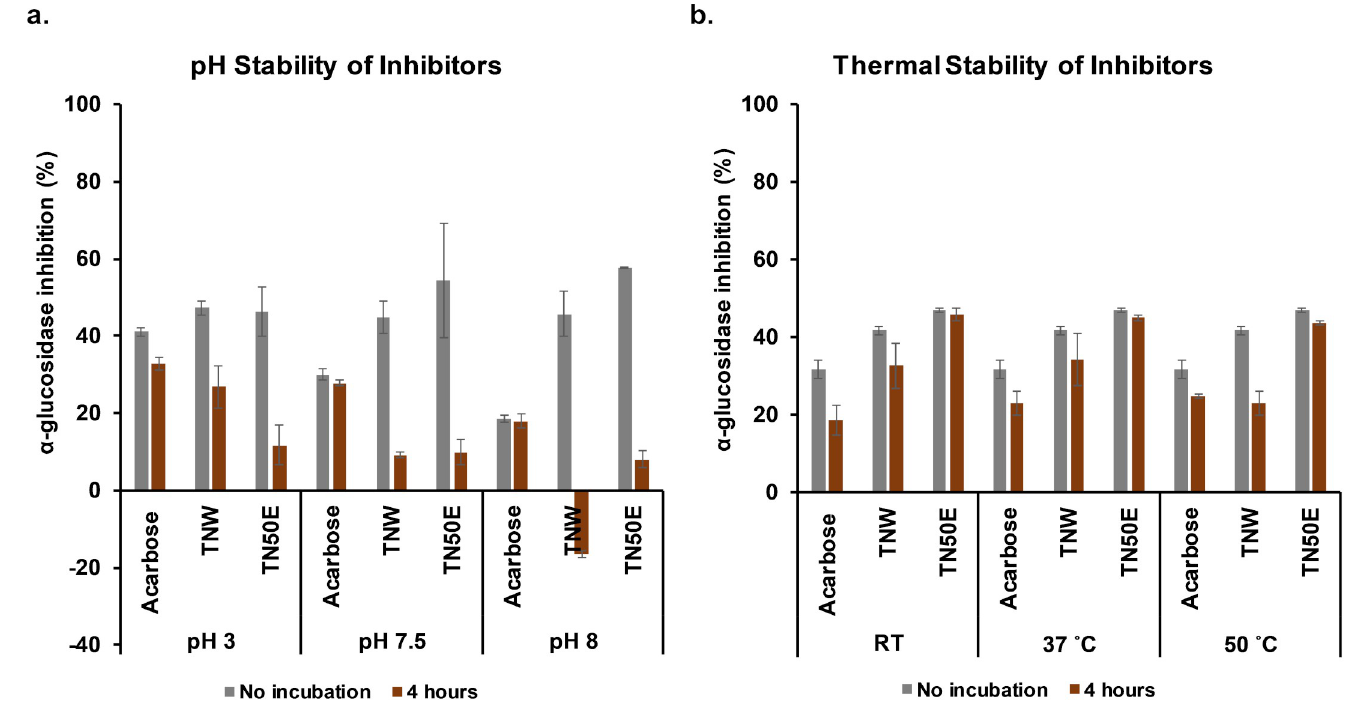
Fig 4. Thermal and pH stability of TN extracts. (a) pH stability of TN extracts (TNW and TN50E) compared to acarbose. Extracts were incubated at pH 3, 7.5 and 8 for 4 h at 37˚C and their inhibitory effect was determined in the standard assay (pH 6.8). (b) Thermal stability of TN extracts (TNW and TN50E) compared to acarbose. Extracts were incubated at room temperature (RT), 37˚C and 50˚C for 4 h their inhibitory effect was determined in the standard assay (37˚C). Mean values are presented and bars represent standard deviations.